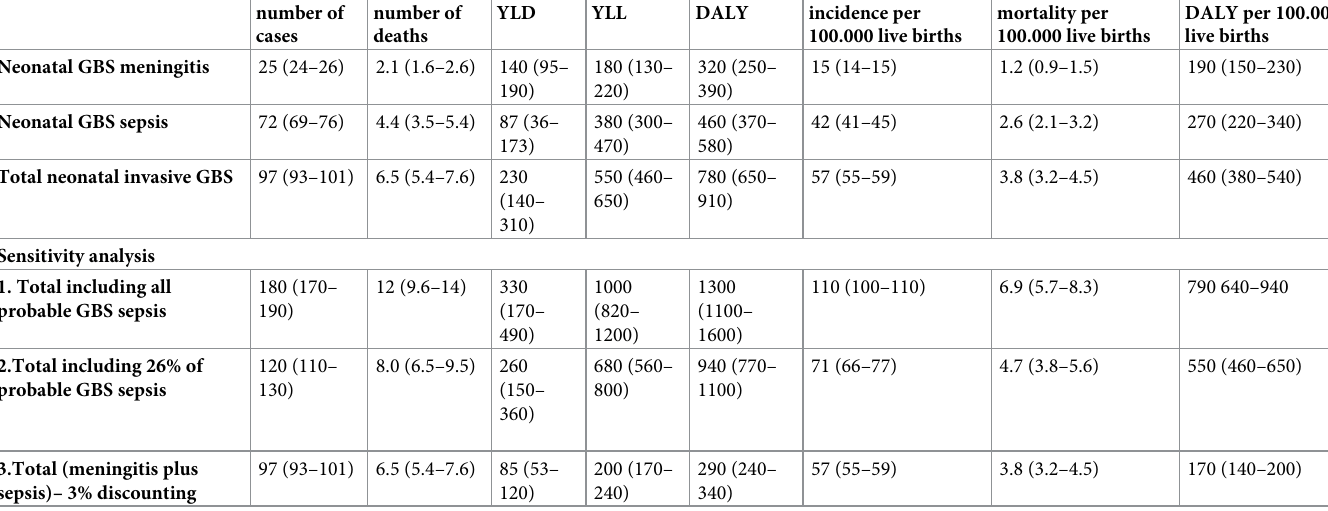
Table 3. Model results for the disease burden of neonatal invasive GBS disease burden in the Netherlands, 2017, presented as medians with 95% confidence interval.